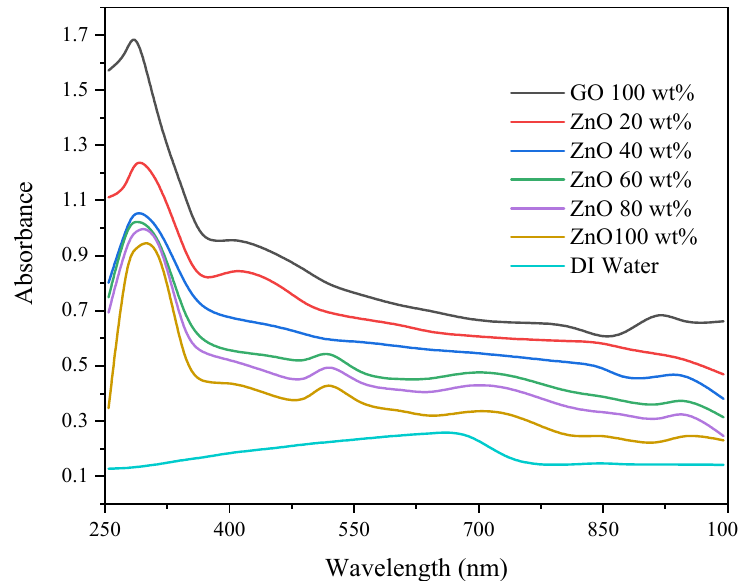
Figure 4. UV absorption spectra of GO–ZnO binary nanocomposites at 0.0004 wt % concentrations.